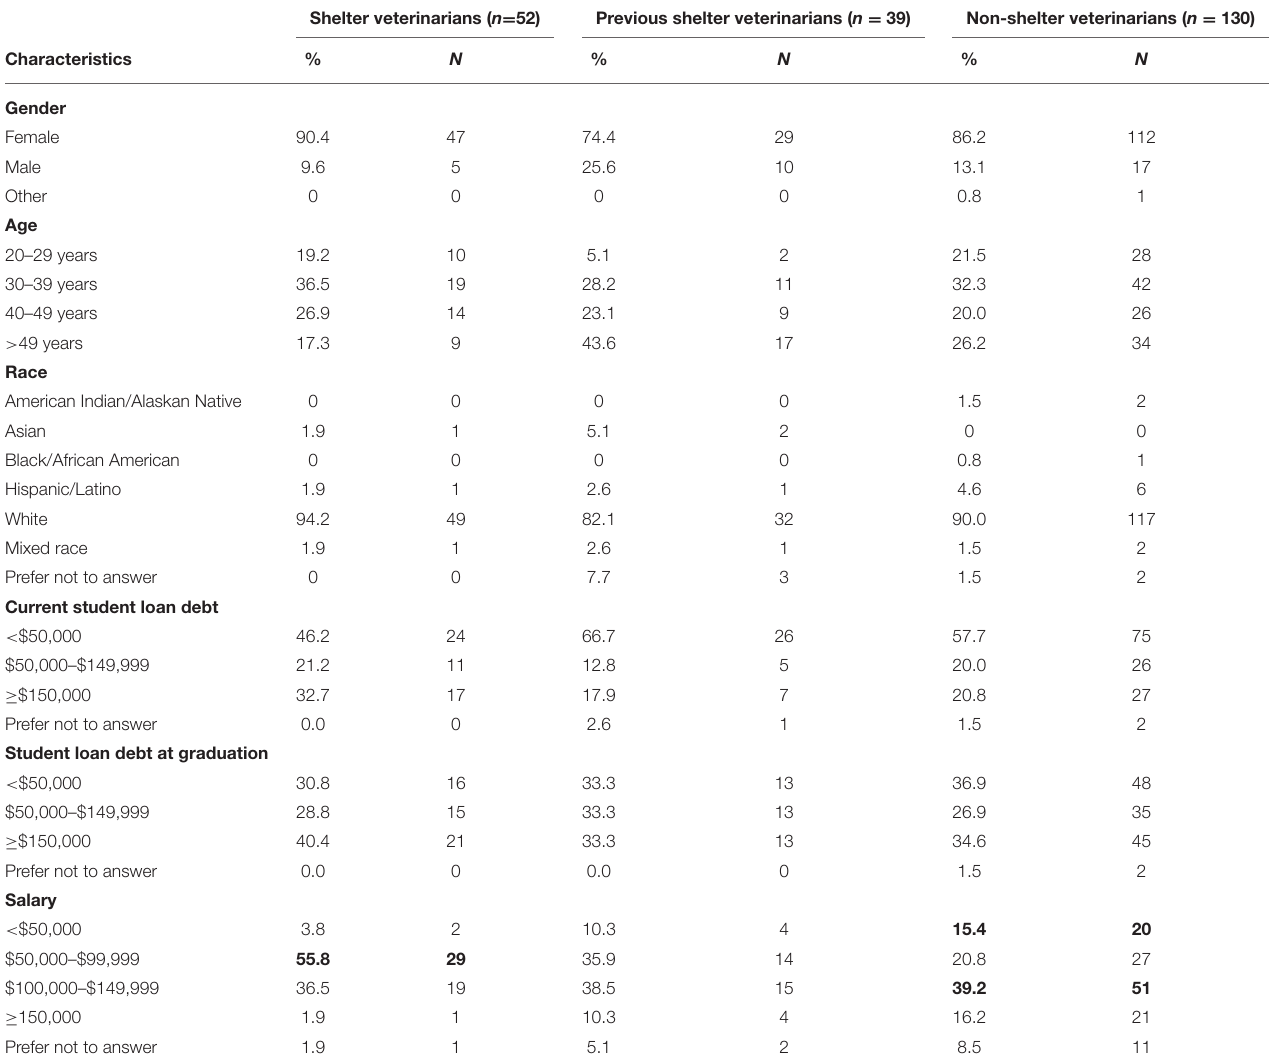
TABLE 1 | Descriptive characteristics of study sample. Shelter veterinarians ( n = 52) Previous shelter veterinarians ( n =